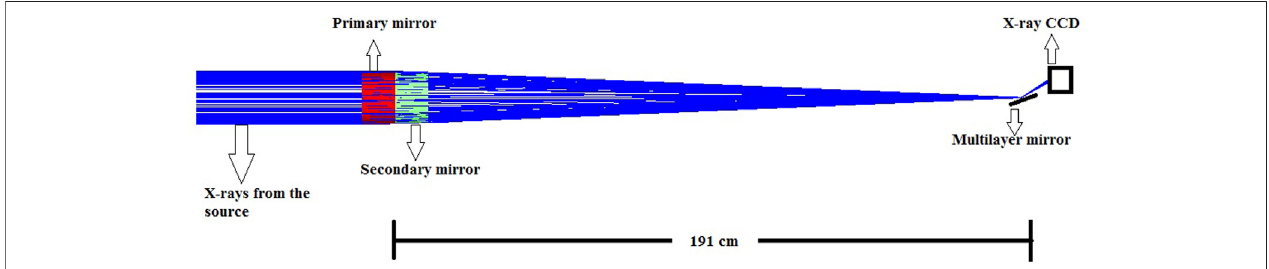
FIGURE 1 | Schematic diagram showing the layout of the spectrograph. The X-ray telescope has a focal length of 191 cm. Multi-layer mirror is placed at the focus of the telescope at a speci fi c angle to re fl ect the narrow band of X-rays to the detector at 10 cm